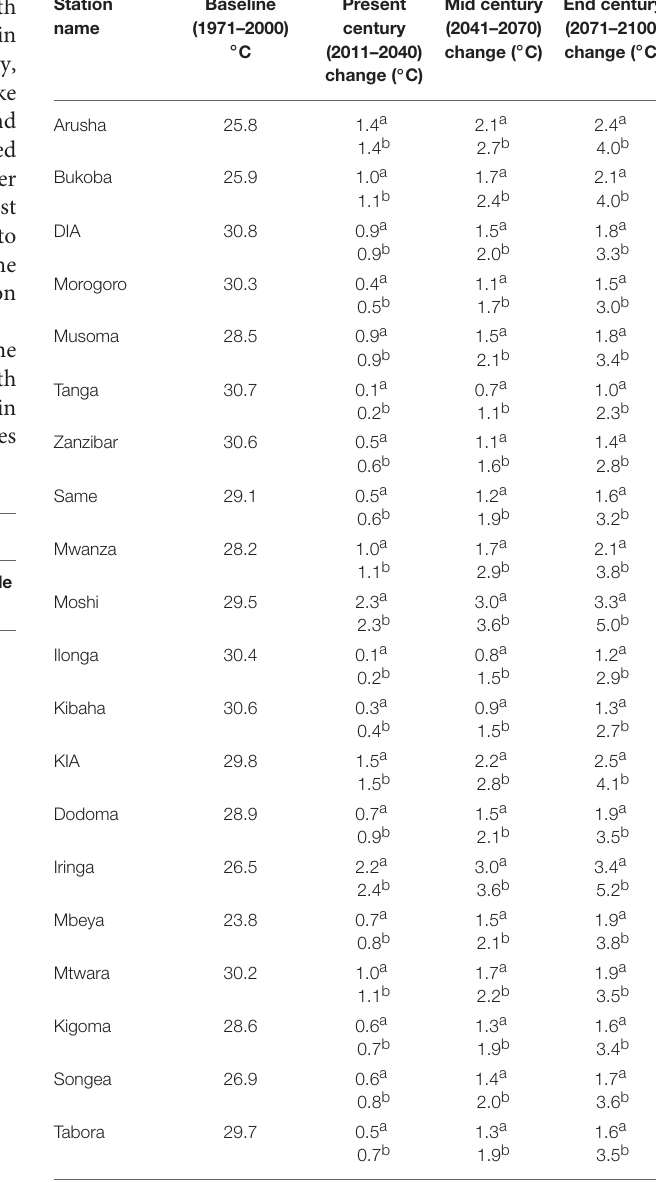
TABLE 3 | Projected change in maximum temperature across representative regions over